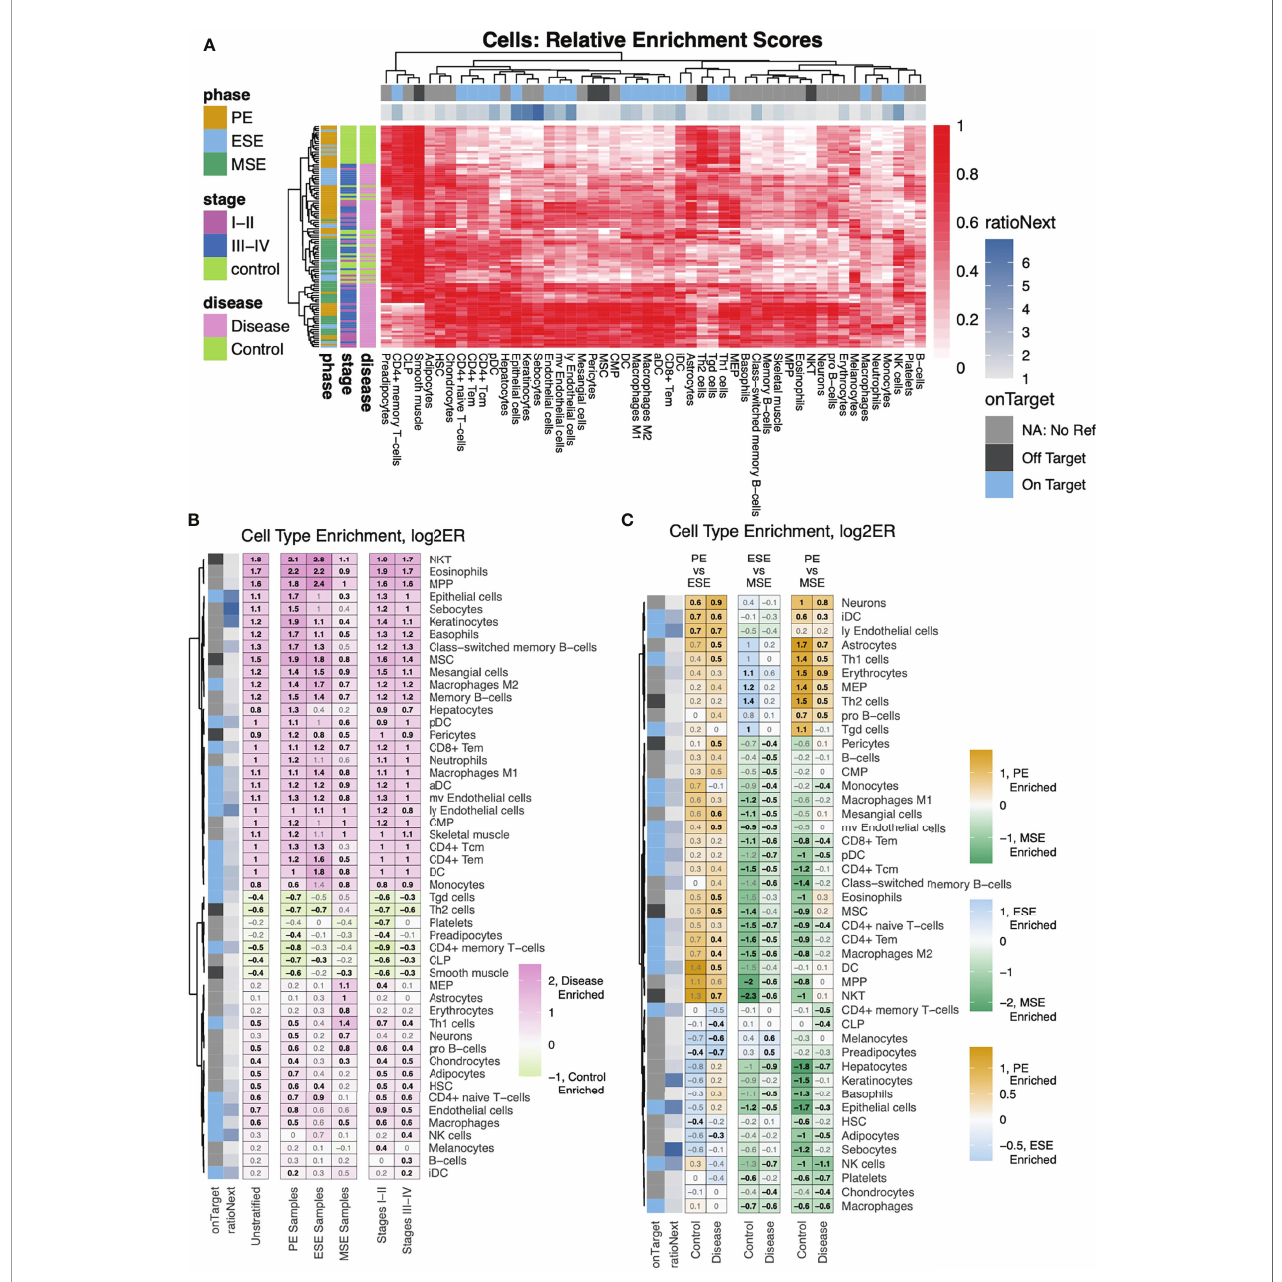
FIGURE 4 | Differential analysis of cell-type enrichment. (A) Heatmap showing, for all samples, relative (compared to the max per cell type) enrichment scores, of all cells determined to be differentially enriched, for any strati fi cation analyzed. (B, C) Cell-type enrichment analysis was performed based on FDR-corrected, two-sided, Mann – Whitney U tests between (B) disease versus control for either all samples (Unstrati fi ed) or strati fi cations to just speci fi c phases (PE Samples, ESE Samples, MSE Samples) or between Stages I – II (labeled as such) or Stages III – IV (labeled as such) versus control among samples from all phases or (C) between phases among case and control samples separately. Shown are heatmaps of log2 fold changes for enrichment scores where only cell types with at least one signi fi cant comparison are shown. Numbers = log2FC with black color for statistically signi fi cant enrichments and gray color for nonstatistically signi fi cant